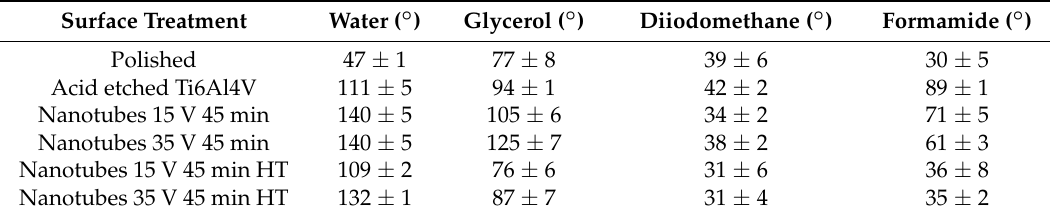
Table 4. Nanotube geometric